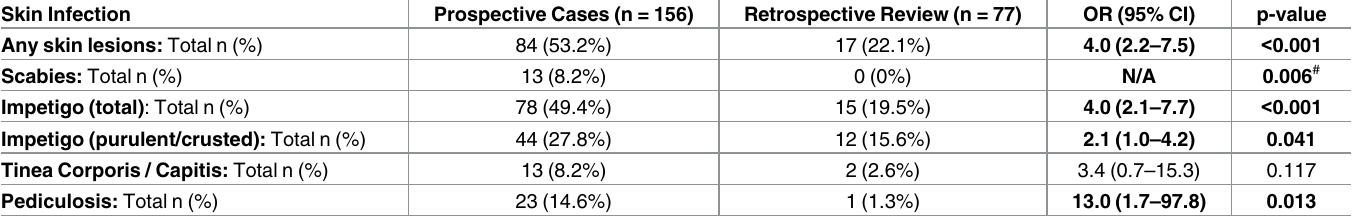
Table 2. Prevalence of skin infection–prospective vs